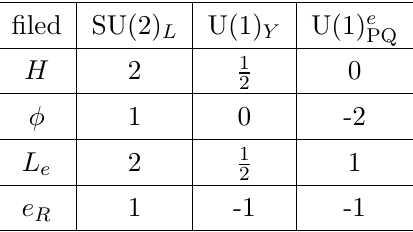
U(1) Y U(1) e charge speci(cid:12)ed, where U(1) e PQ (cid:2) (cid:2)